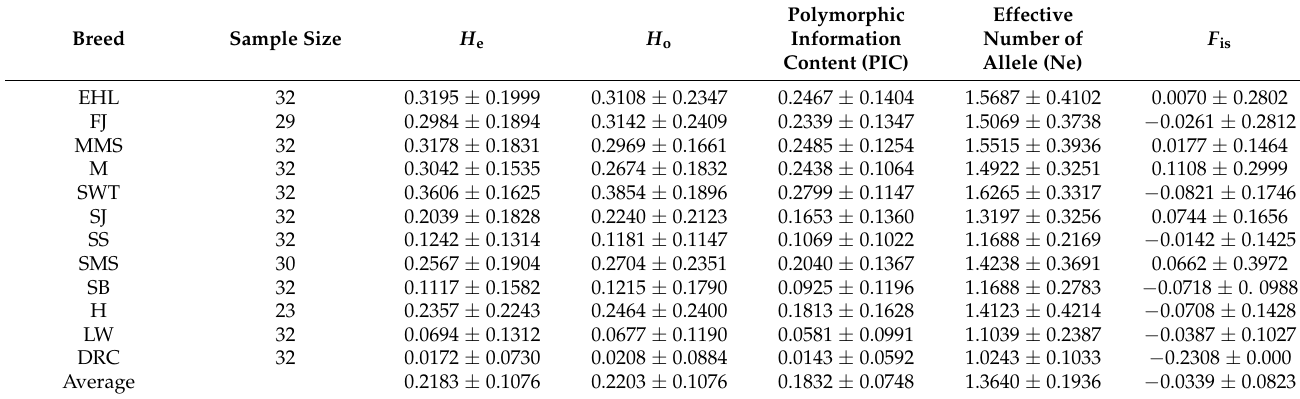
Table 2. Genetic parameters generated by the 18 SINE RIPs.